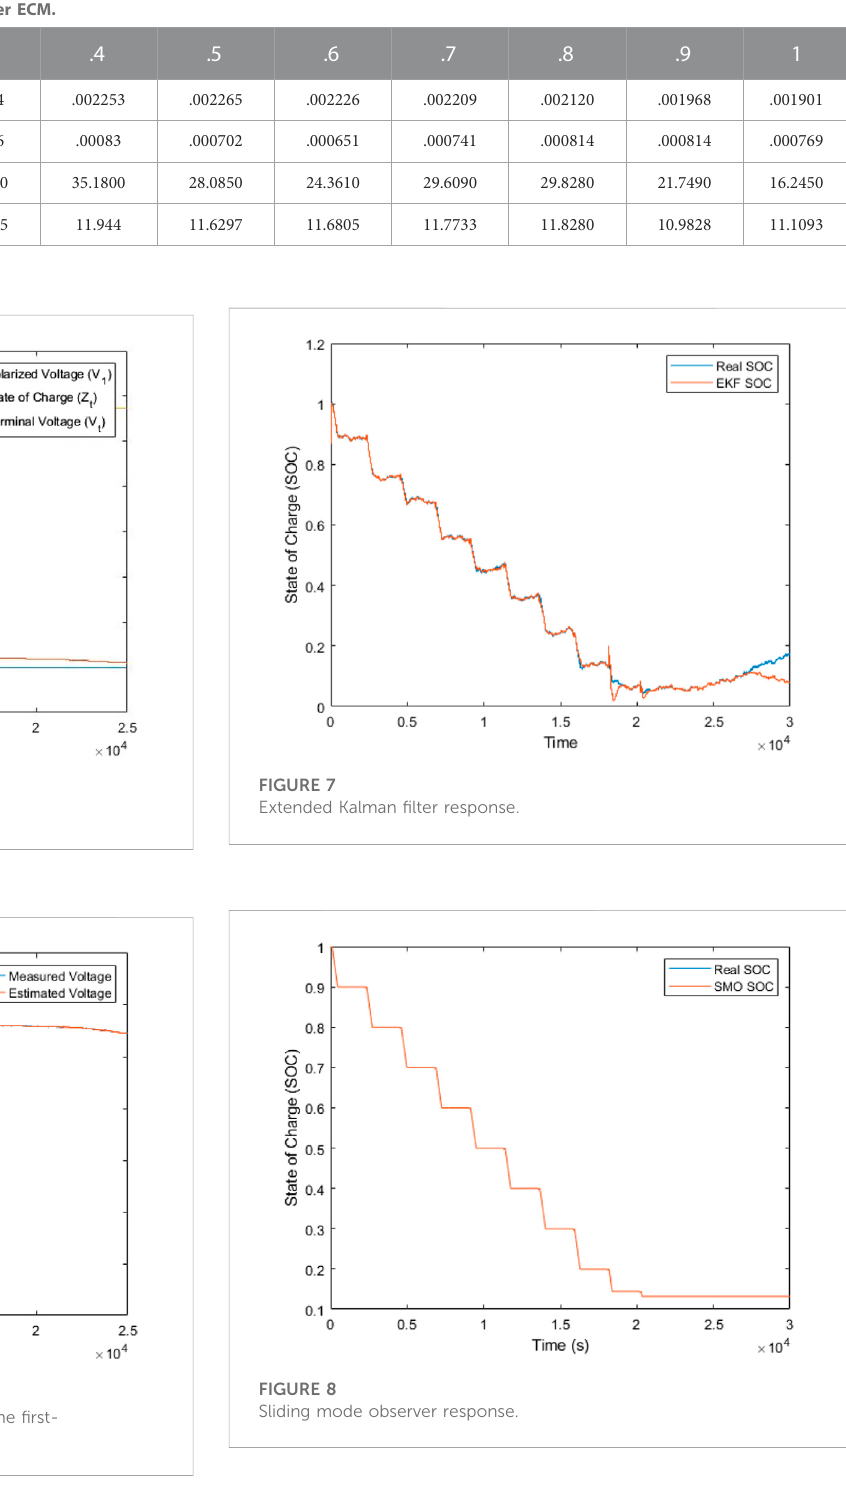
TABLE 4 Estimator performance